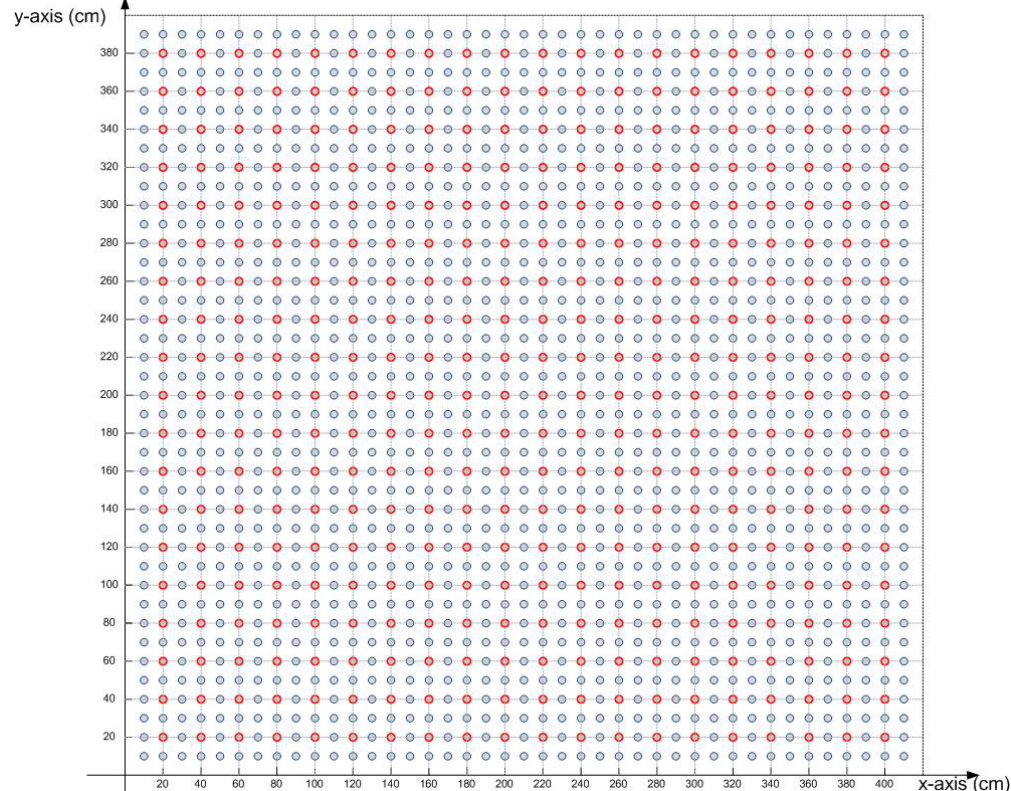
Figure 11. Distribution of receivers in the room in the xy